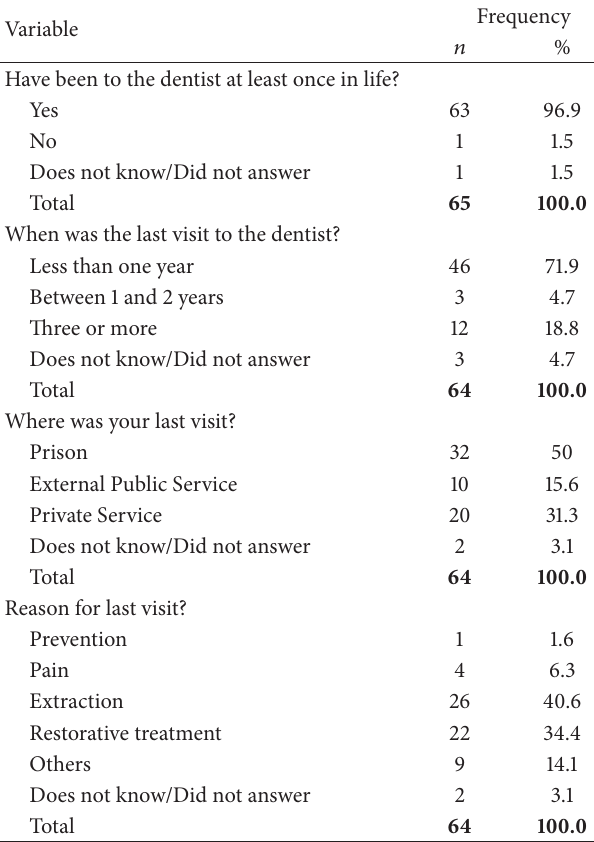
Table 2: Distribution of inmates according to the use of dental